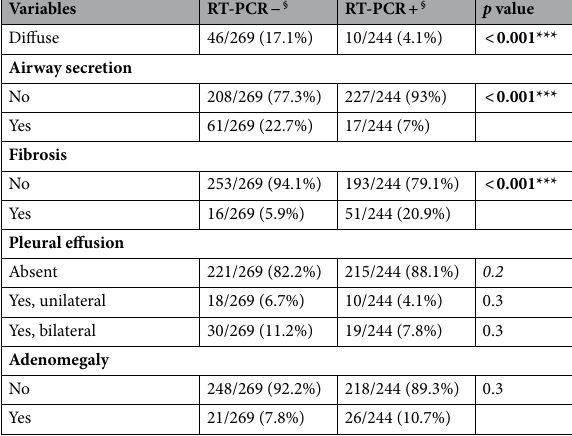
Table 3. Univariate associations between radiological features and RT-PCR status. P-values in bold correspond to significant associations between clinical or radiological features and RT-PCR status. Regarding variables with more than two levels, the p value in italics corresponds to the p-value considering all its levels. The p-values below are based on the Fisher or X 2 test for this variable that was dichotomized according to the level of the line. GGO ground-glass opacities. § Data refer to number of patients with percentage in